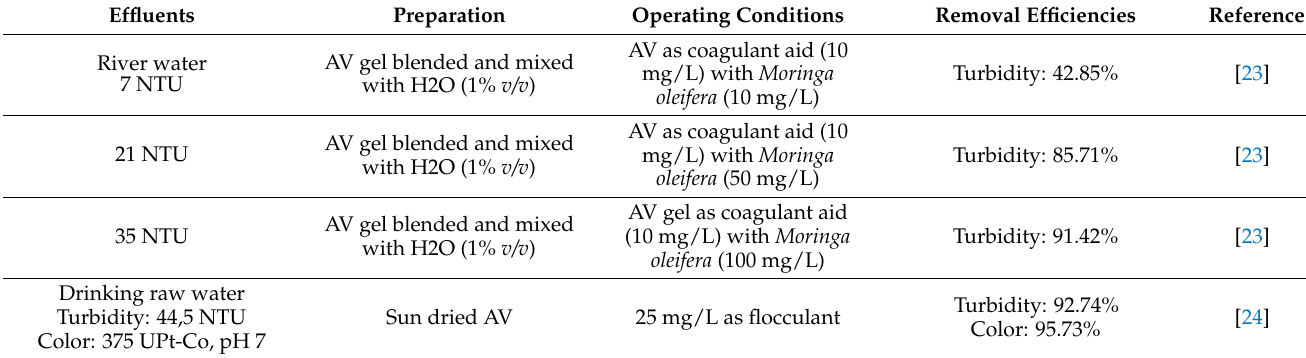
Table 1. Pollutants removal by coagulation–flocculation using Aloe